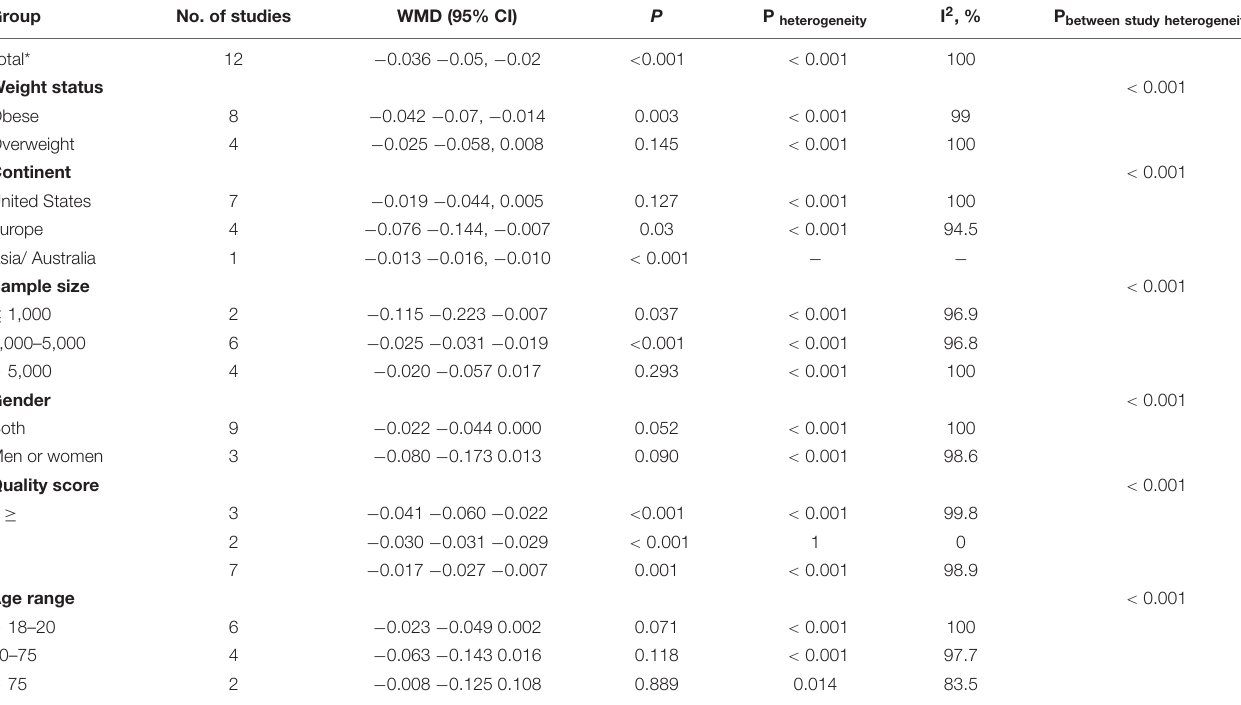
TABLE 4 | Results of subgroup analyses of the comparison of relative telomere length (rTLT) in obese vs. non-obese individuals according to the study or participants “characteristics”.